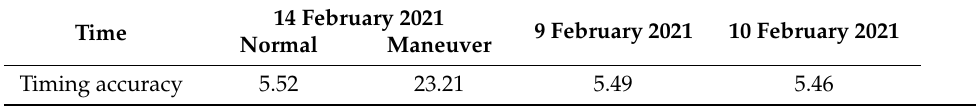
Table 2. The accuracy of the RDSS one-way timing service (orbit maneuver state, RMS, unit: ns). Time